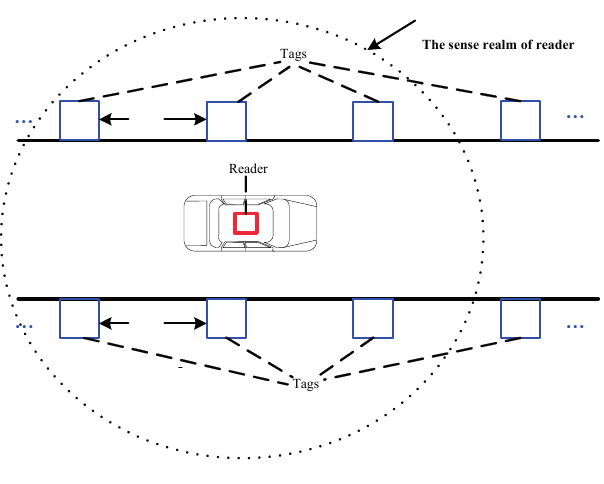
Figure 2. The RFID tag layout